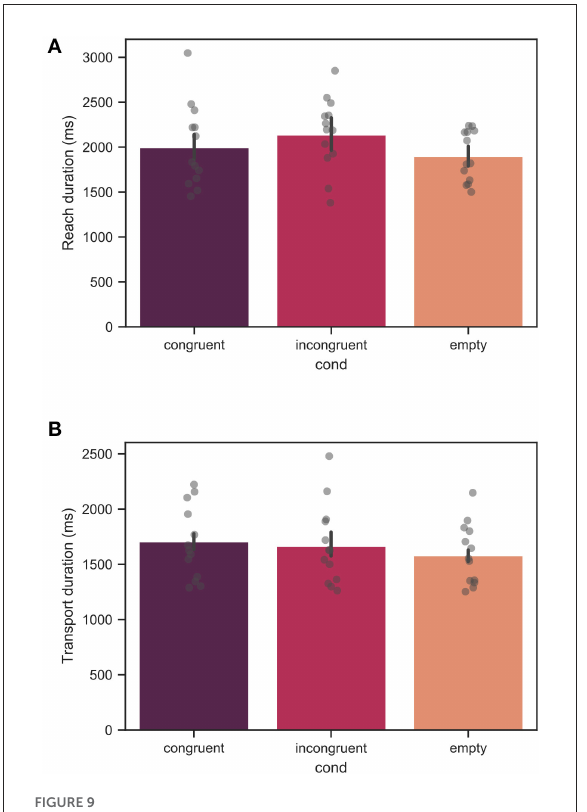
FIGURE9 Mean duration of the (A) reach phase, and (B) transport phase across all trials for all measured participants. Each bar corresponds to a separate experimental condition. The error bars indicate confidence intervals of 95% computed using bootstrapping (see main text). The individual points correspond to the mean value for each individual participant. For the reach phase, the effect of condition was not significant. For the transport phase, the difference between the congruent and empty conditions was significant with p < 0.01, whereas no significant difference was found between the congruent and incongruent conditions.